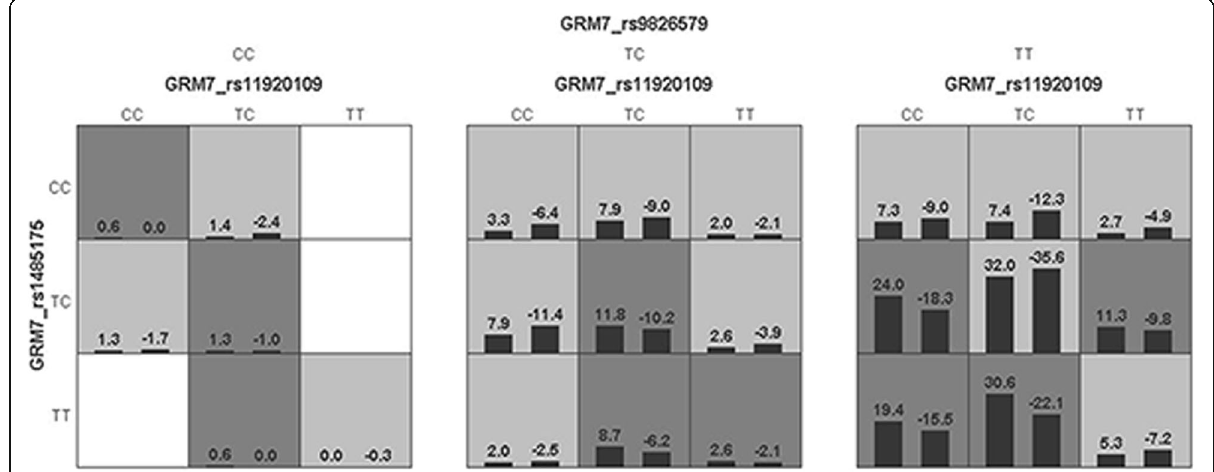
Fig. 3 Best model gained by the analysis of GMDR. The implications of bars and background color in each multifactor cell are as follows. The left bars represent the sum of scores in case and the right represent the control. High risk cells are expressed by black shadow if the ratio of the number of cases to the number of controls exceeds the preset value T, as low risk cells by light shadow if not more than the threshold and empty cells by no shadow which means no cases and controls. The multifactor cells labeled as “ high risk ” or “ low risk ” are then used to assess the classification